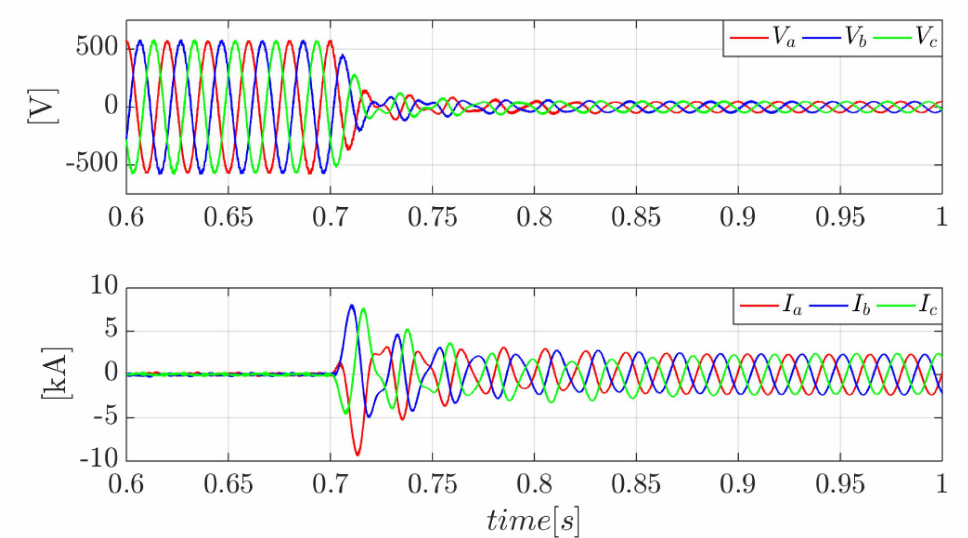
Figure 17. GFM converter instantaneous voltage and currents during a balanced fault with 0.95 p.u.